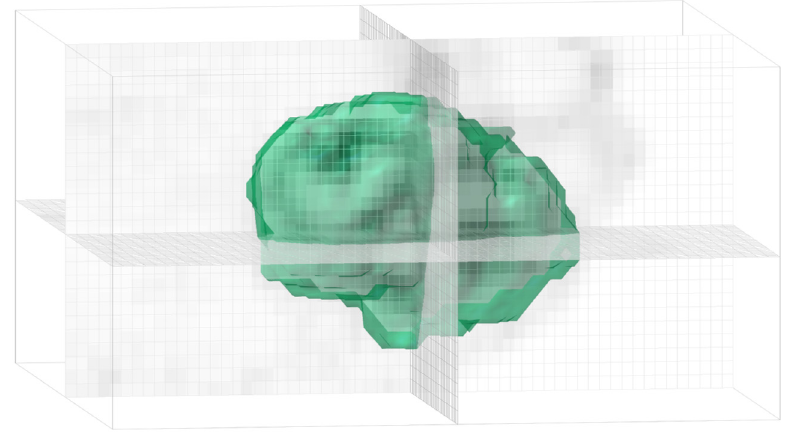
Figure 6. Bubble chain morphology and low sphericity (0.56) in the three-dimensional representation of the segmented tumor of patient 2 (see Figure 5).